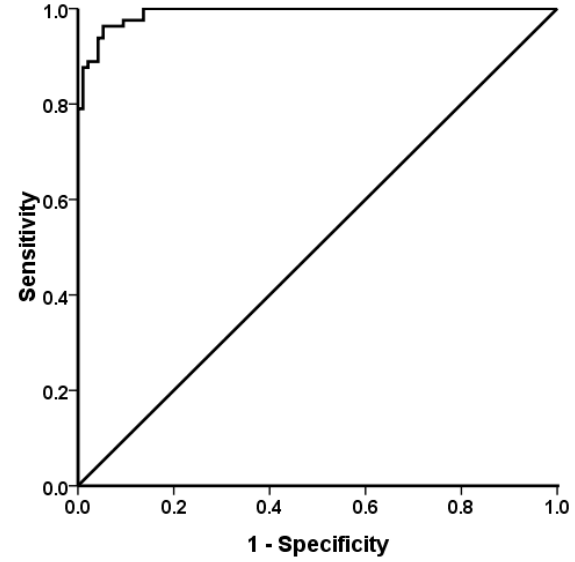
Figure 1. Receiver operating characteristic curve of plasma circulating cell-free DNA in 81 patients with esophageal squamous cell carcinoma and 95 normal controls. The sensitivity was 96.3% and